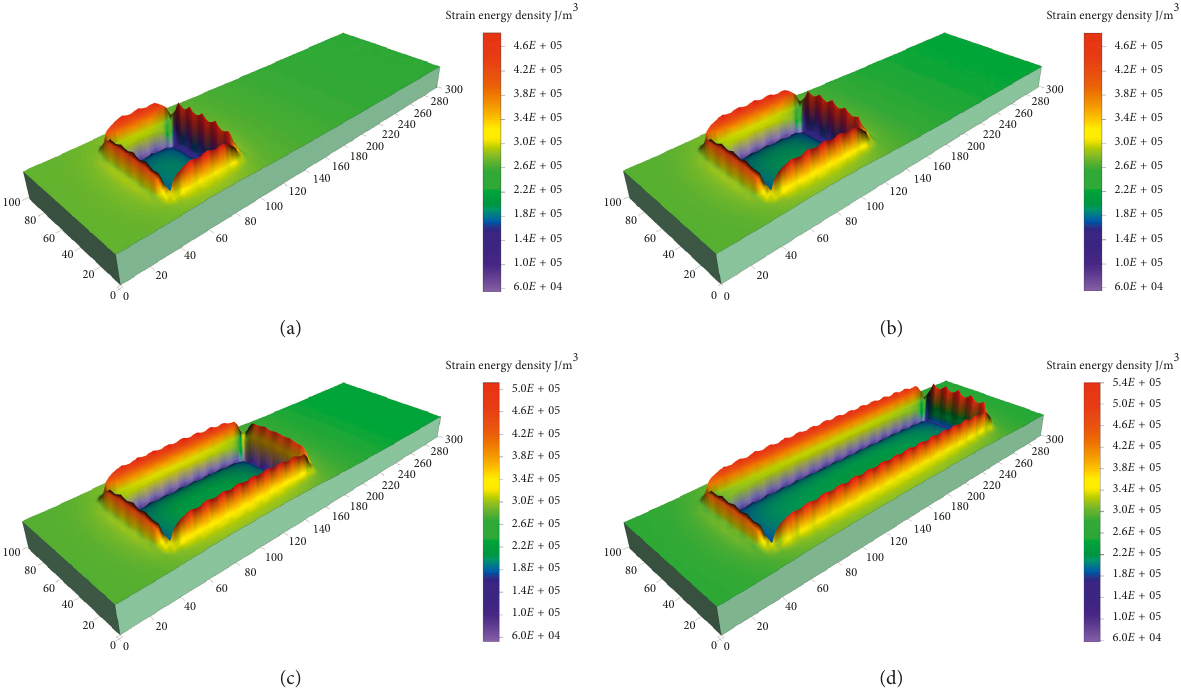
Figure 8: Distribution of strain energy density at different advancing distances when using backfilling mining method. (a) Working face advanced to 48 m. (b) Working face advanced to 72 m. (c) Working face advanced to 112 m. (d) Working face advanced to 200